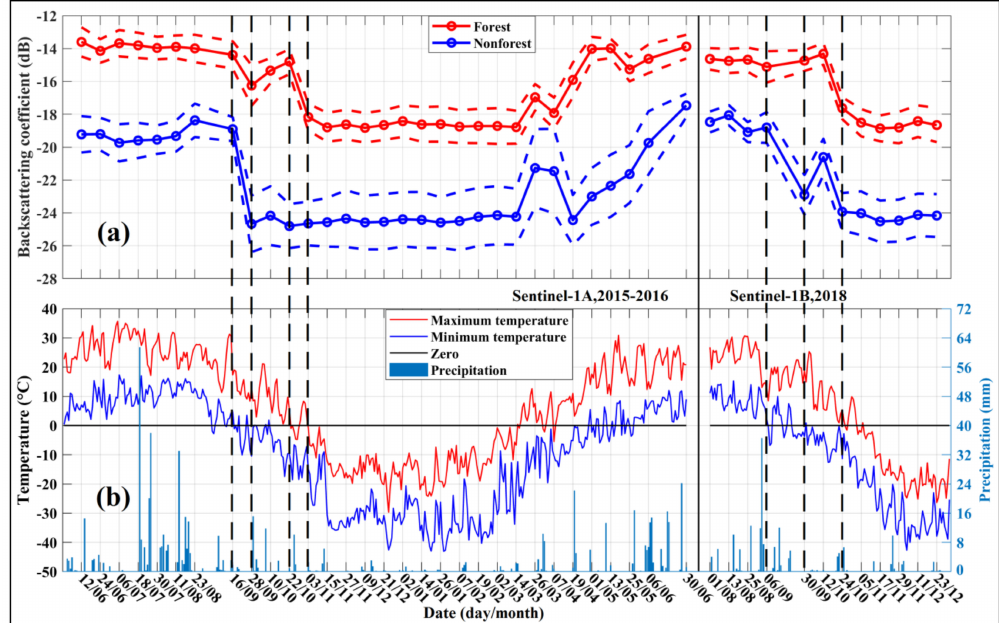
Figure 5. Time series of VH backscattering coe ffi cients on the type I and type VII sampling plots of the first group and corresponding daily temperatures and amount of precipitations within the scene of Strip-1-1: ( a ) Backscattering coe ffi cients of forest plots (in red) and non-forest plots (in blue), solid lines are the mean values and dotted lines are standard deviations; ( b ) Daily temperatures and amount of